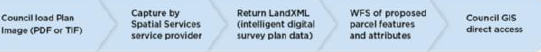
Figure 3 . Streamline process of LandXML WFS (Spatial Services 2021)